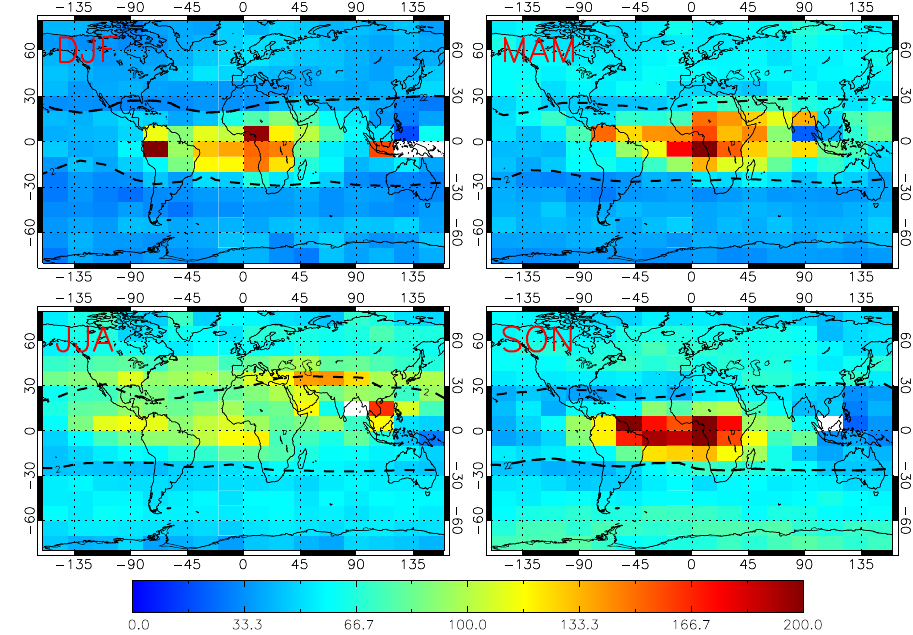
Figure 3. As Fig. 2 but for the UoL MIPAS